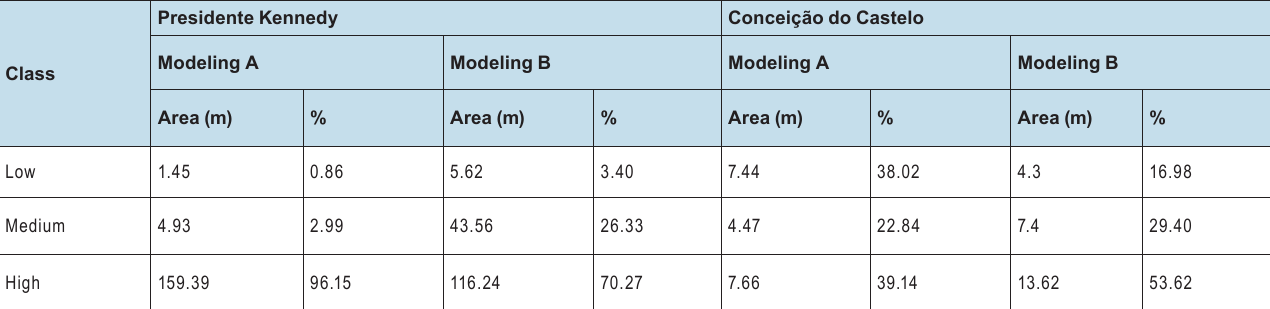
table 3 - Quantification of areas in the low, moderate and high susceptibility classes according to flooding Models A (based on the susceptibility of sub-basins), and B (based on the relief patterns